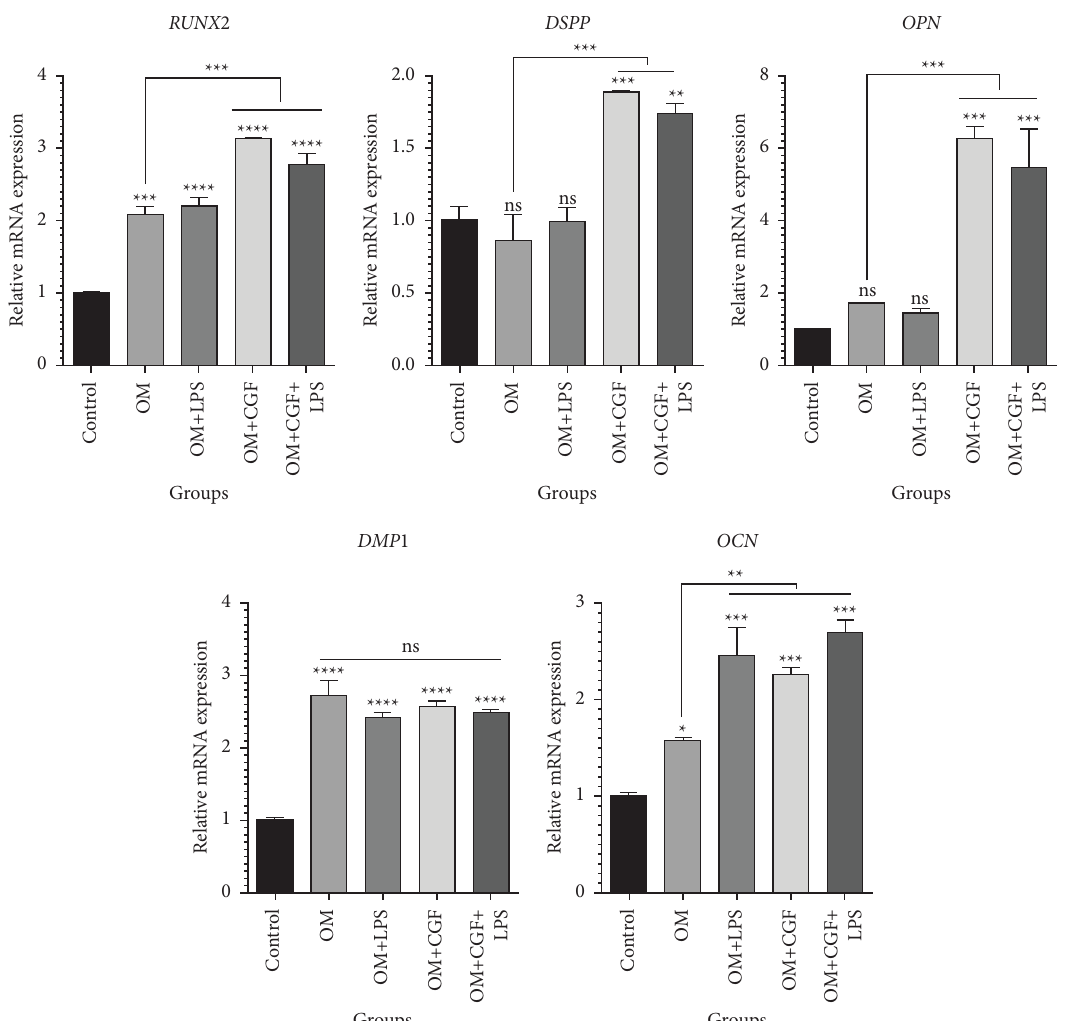
Figure 7: Te results of the qRT-PCR assay for the expression levels of osteogenic markers in the treatment groups. ∗∗∗∗ p < 0 . 0001 , ∗∗∗ p < 0 . 001 , ∗∗ p < 0 . 01 , ∗ p < 0 . 05 and ns � non-signifcant. CGF: concentrated growth factor; LPS: lipopolysaccharide; OM: osteogenic